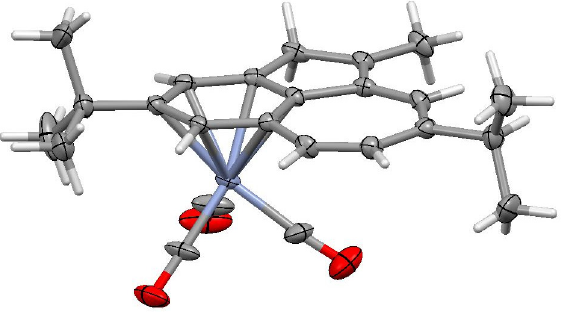
Figure 11. Molecular structure of the 2 H -benz[ cd ]azulene-chromium tricarbonyl complex, 85 .